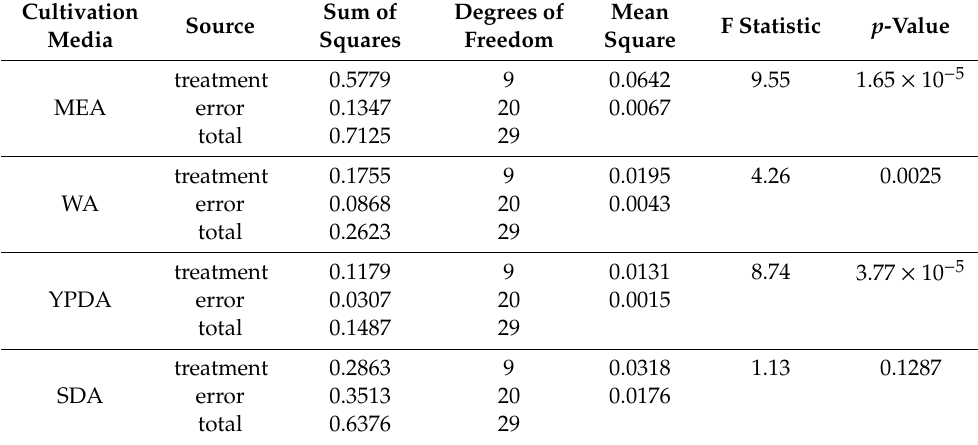
Table 2. One-way ANOVA for analyzed wine varieties—grapes.